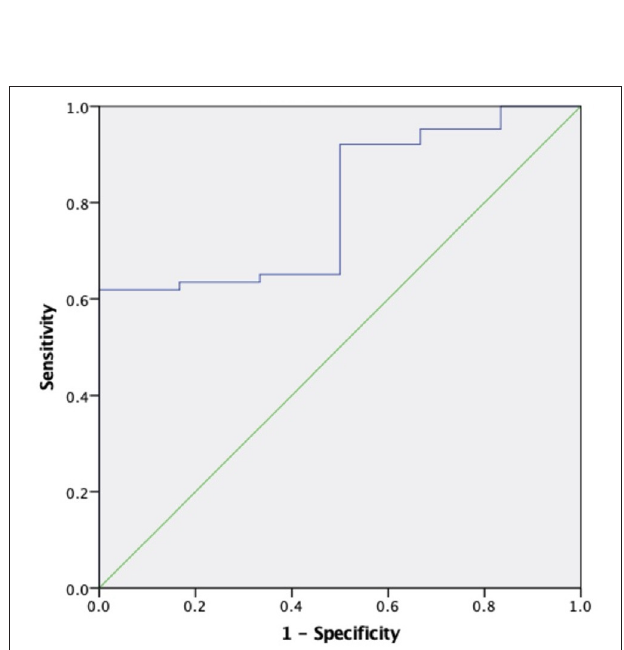
FIGURE 7 | The role of soluble Klotho in predicting the CVD mortality in MHD patients with AAC ≤ 4. The receiver operating characteristic curve illustrates soluble Klotho. Areas under the curves are 0.796 (95% CI 0.647–0.946, P = 0.017) for the soluble Klotho. A cut off valuable of 307.69 pg/ml yielded to good sensitivity and specificity. The sensitivity and specificity are 92.1 and 50%,